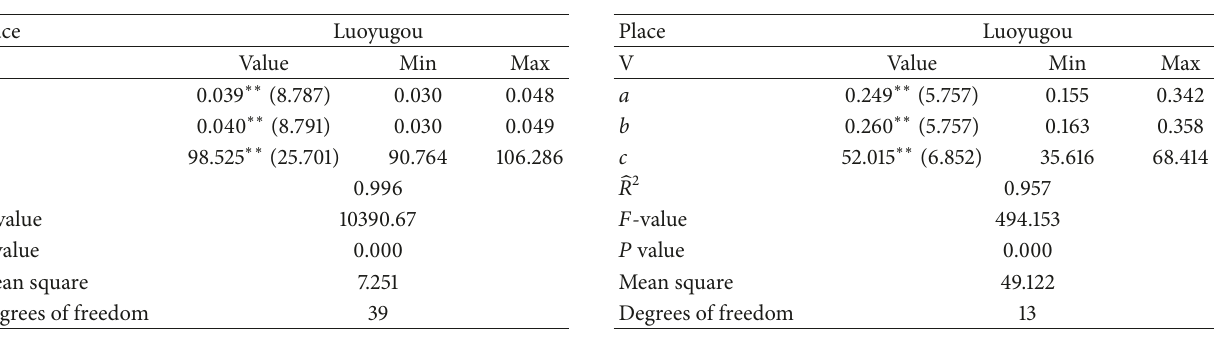
Table 10: Fitting parameters of empirical model on L-3 by laser diffraction technique.